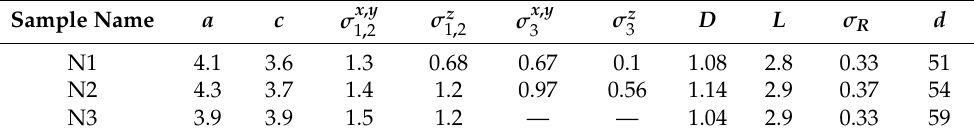
Table 2. Parameters of the formed QW lattices of the as-grown films found by GISAXS analysis: in-layer dot separation a , multilayer period c , deviations of the QW positions from the ideal ones ( σ x , y , σ z , σ x , y , σ z ), QW diameter ( D ) and length ( L ), the standard deviation of their distribution σ R , 3 1,2 3 1,2 and the film thicknesses d . All values are given in nm.